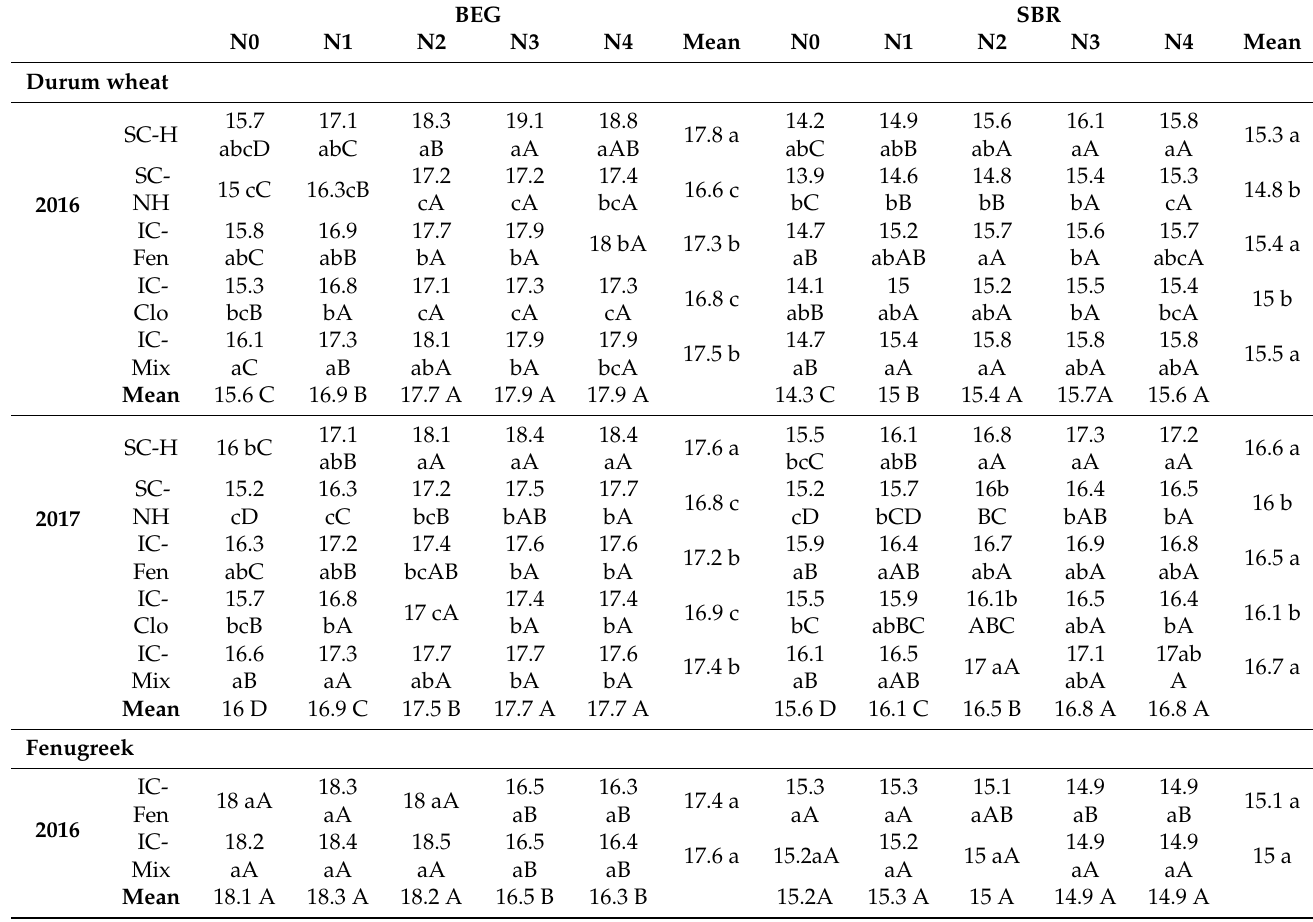
Table 2. Effect of different cropping patterns and N treatments on the net photosynthetic rate ( Pn , µ mol CO 2 m − 2 s − 1 ) of durum wheat, fenugreek and clover at flowering stage in 2016 and 2017